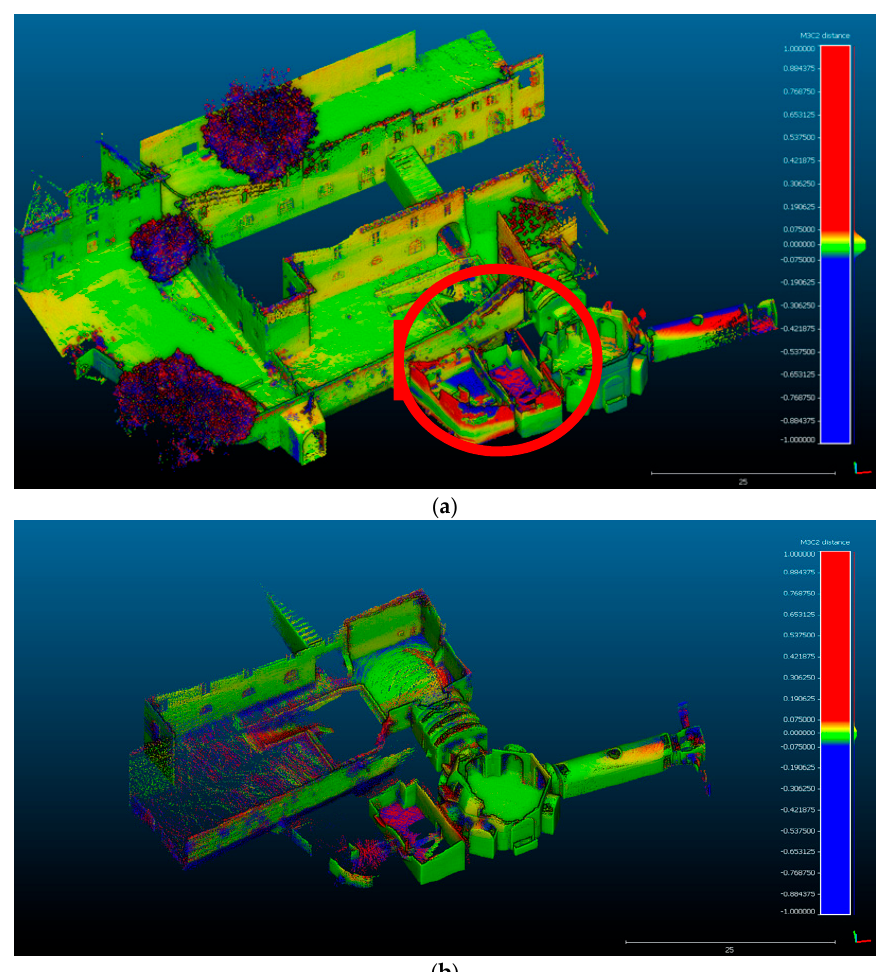
Figure 7. Signed distances of the Kaarta Stencil dataset compared to the ground truth: ( a ) path 1; ( b ) path 2.